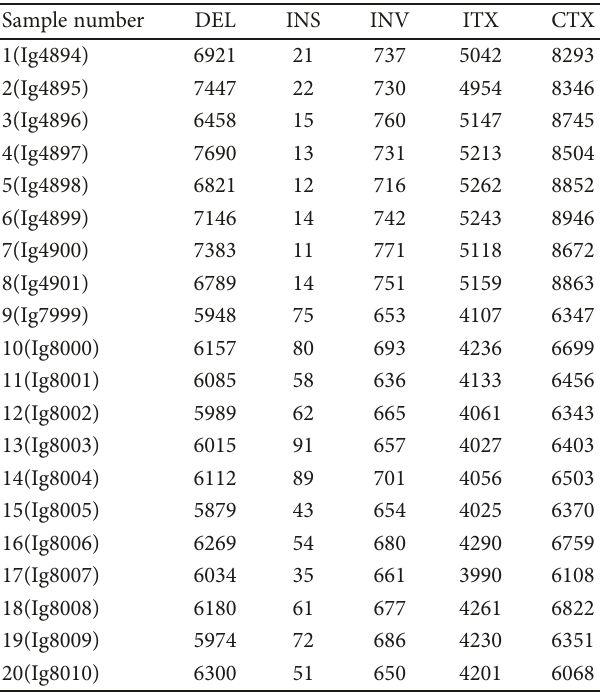
Table 4: Structural variations detected in the genomes of 20 greater